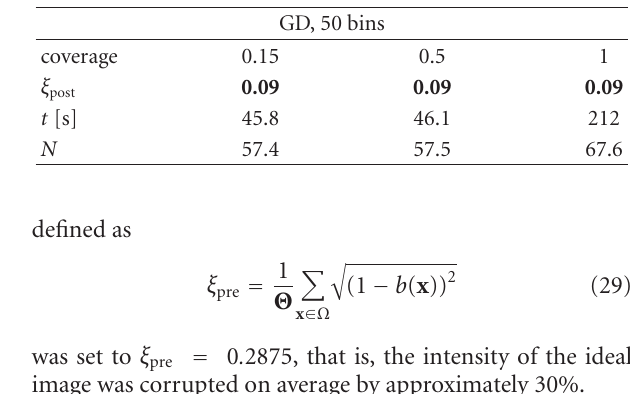
Table 2: Influence of di ff erent number of samples used for entropy evaluation on the algorithm precision and